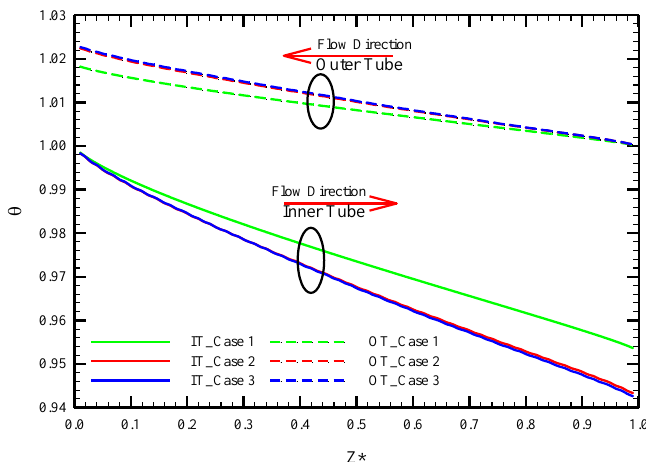
Figure 5. Local bulk temperature distribution along the length of the tube for PHE, Co-STT and Counter-STT at Reynolds number of 250.